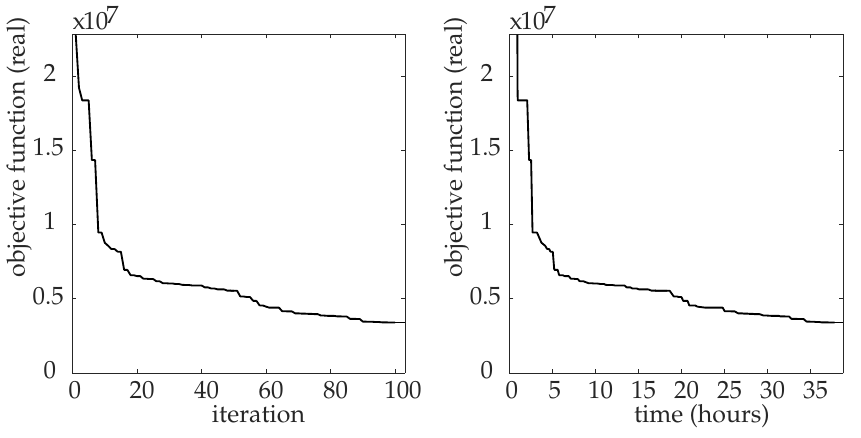
Figure 3. Performance of the GABC for the 136 nodes. Table 6 shows the portion of END of the feeders, as well as the cost of END and the cost of the keys before and after the optimization. The allocation of automatic keys is predominant in this case, rising from 0 to 71, while manual keys decrease from 28 to 26. The final undistributed energy of the network is 97.35% lower than the initial one, showing a drop of BRL 85,357,177.00. Even reducing the total cost, the greatest weight remains the energy not distributed in the grid. The total cost reduction of the network reduces by 3.87%, equivalent to BRL 84,391,494.00. The optimal setup for 136-bar network which reached such metrics is presented in Figure